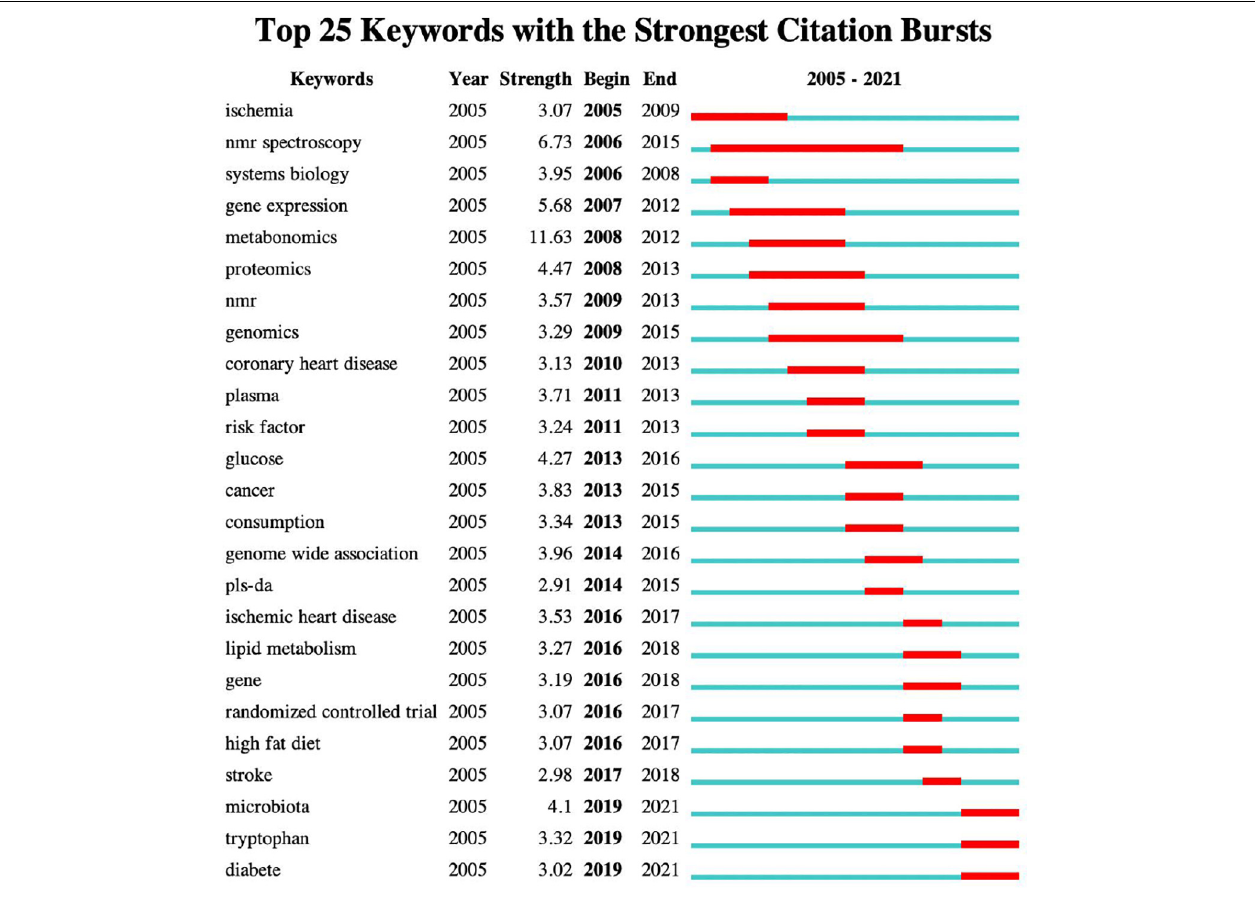
FIGURE 6 | Keywords with the strongest citation bursts. The blue line indicates the timeline, and the red segment on it indicates the duration of the